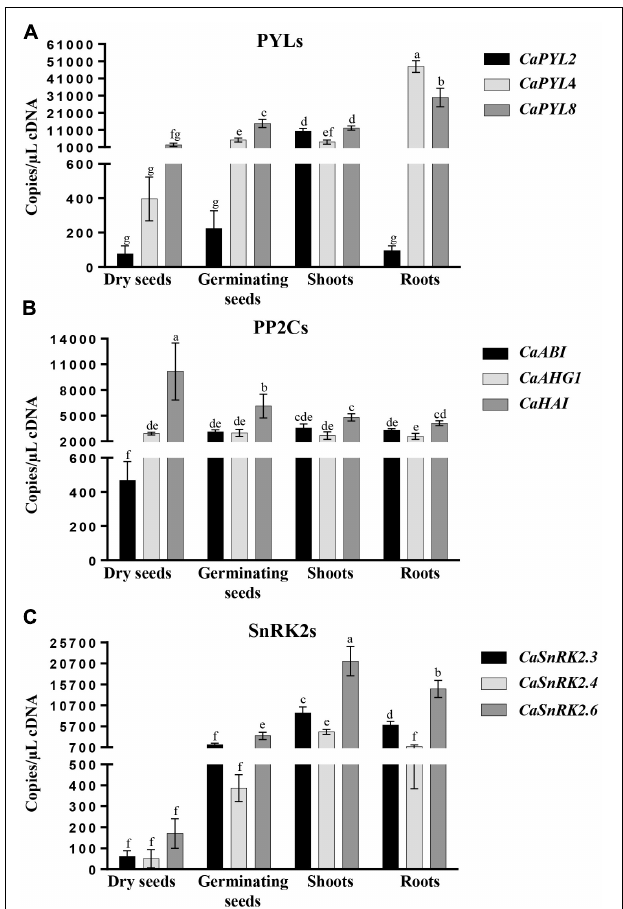
FIGURE 4 | Gene expression analysis in dry seeds, germinating seeds, shoots and roots of Quadrato D’Asti giallo as monitored by absolute qRT-PCR. Expression of PYR/PYL/RCAR ( PYL ) (A) , PP2C (B) , and SnRK2 (C) gene families. Values indicate mean ± SD ( n = 3). Different letters indicate significant difference at P < 0.05 (Duncan test).